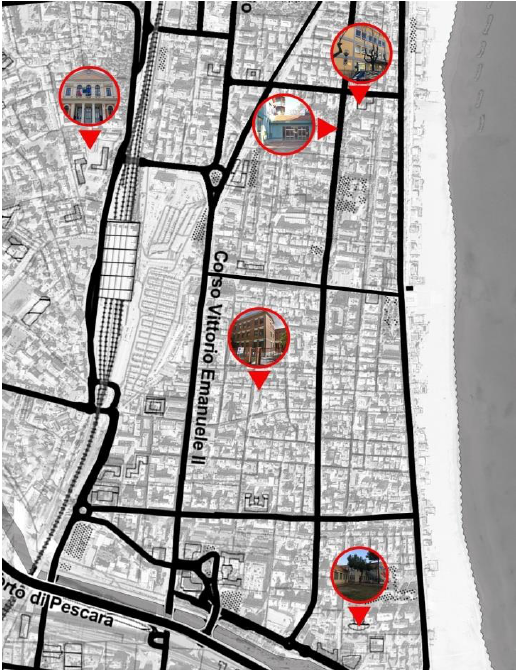
Figure 1. Pescara plan with location of 5 school